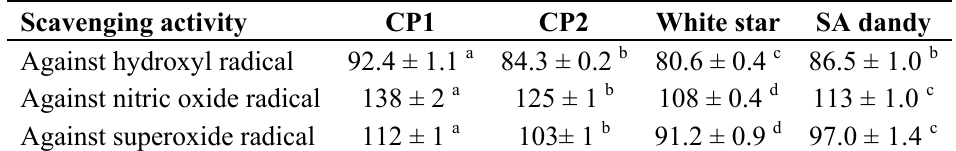
Table 4. Antiradical activity [IC ( μ g/mL)] of the extracts of cowpea seeds. 50 Scavenging activity CP1 White star Against hydroxyl radical Against nitric oxide radical Against superoxide radical Mean values in the same row having different letters differ significantly ( p <